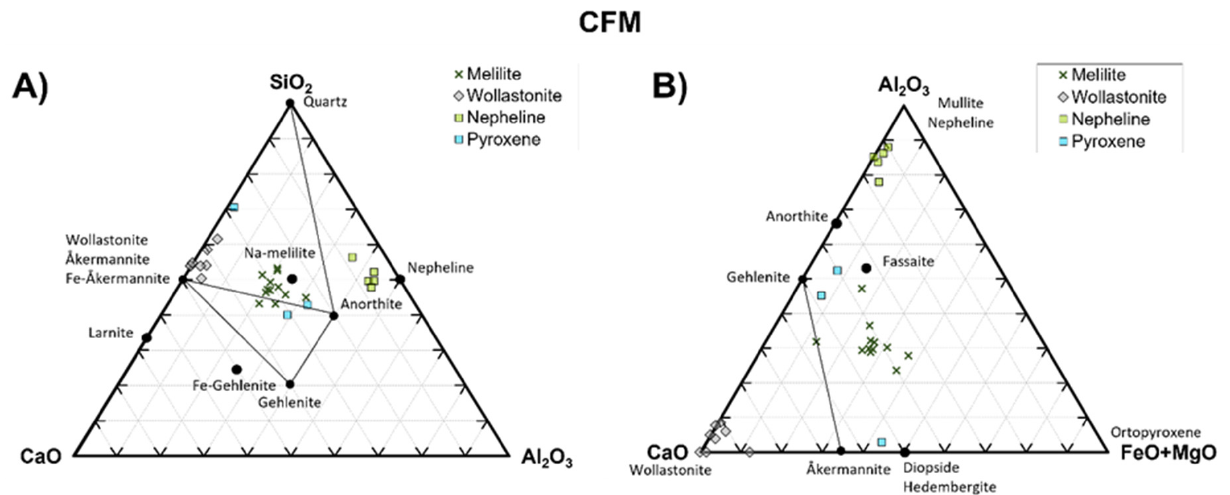
Figure 7. ( A ) CaO-SiO 2- Al 2 O 3 ternary diagram of analyzed mineral phases of CFM sample. ( B ) ACF ternary diagram of CFM sample. Additionally, shown in both diagrams are end-member compositions (black circles) of some typical ceramic minerals.